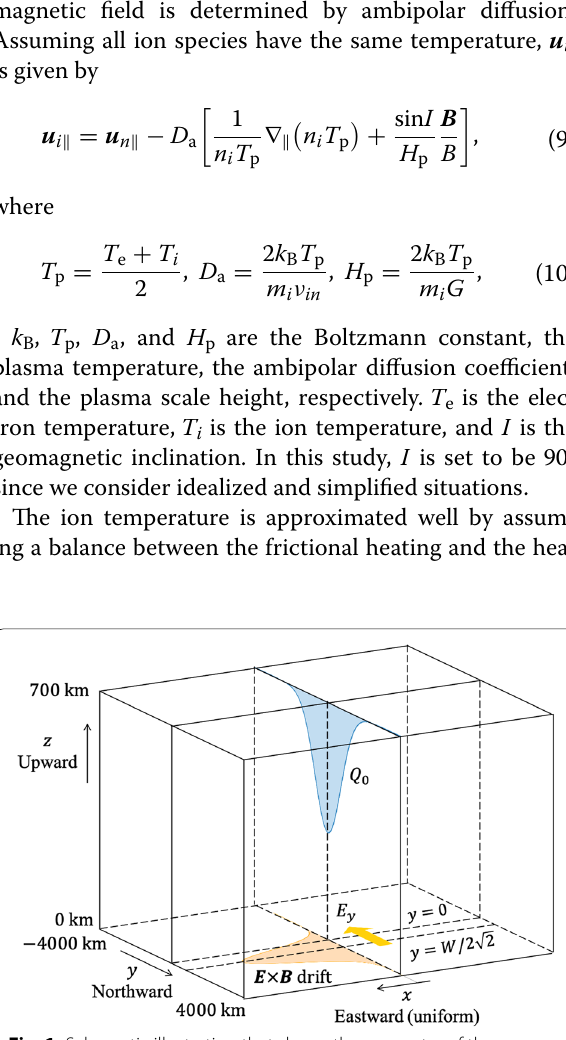
Fig. 1 Schematic illustration that shows the geometry of the simulation. The x -axis, y -axis, and z -axis are directed eastward, northward, and upward. The peak of electron energy flux ( Q 0 ) is located at the center ( y = 0 km). The peak of southward electric field ( E y ) is shifted from the center to the north to maximize the upward field-aligned current at the